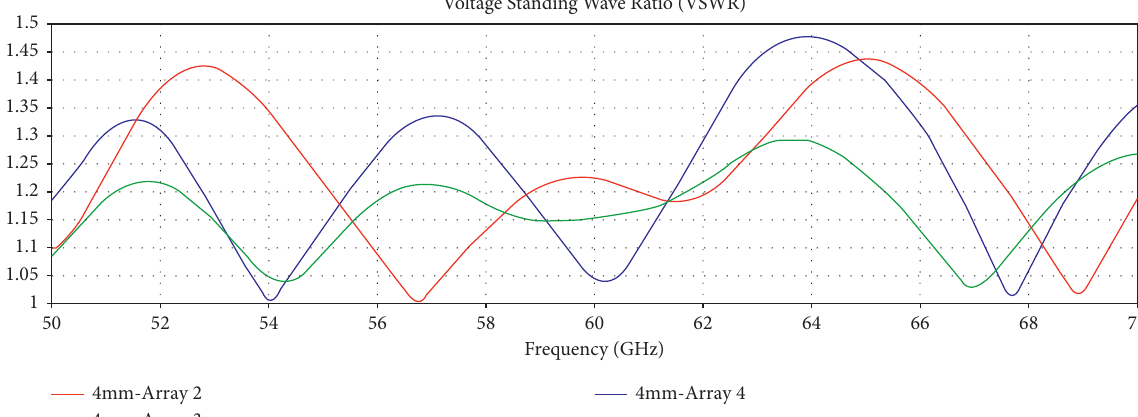
Figure 34: On-body VSWR comparison at 4mm between Array 2, 3, and